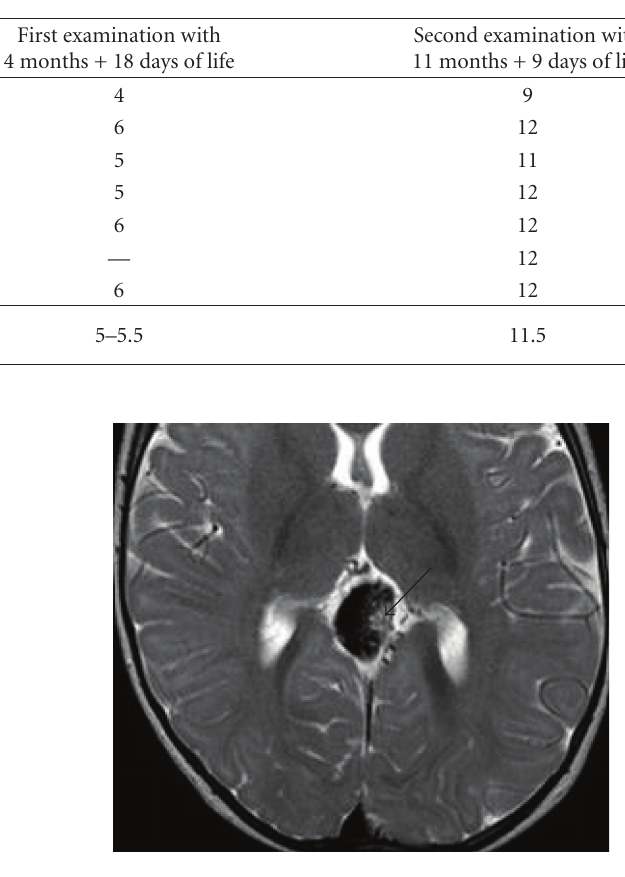
Figure 8: MRI followup control after the first embolization (T2- weighted): dilated Vein Galen after intervention with NBCA-Cast